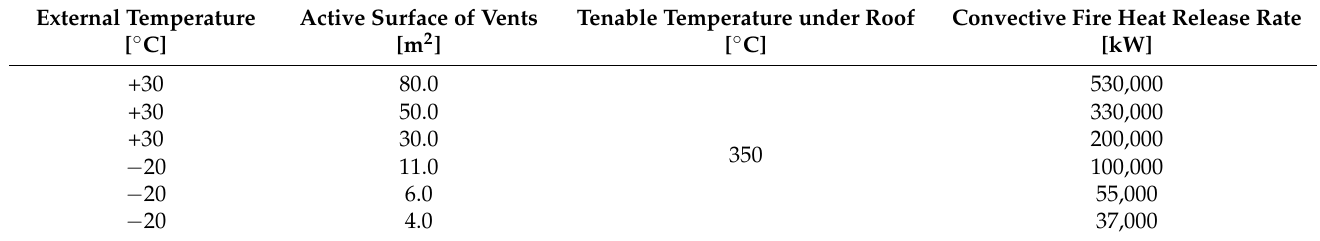
Table 3. The required vents area for keeping under the boiler house’s roof temperature below 350 ◦ C in a fire situation.